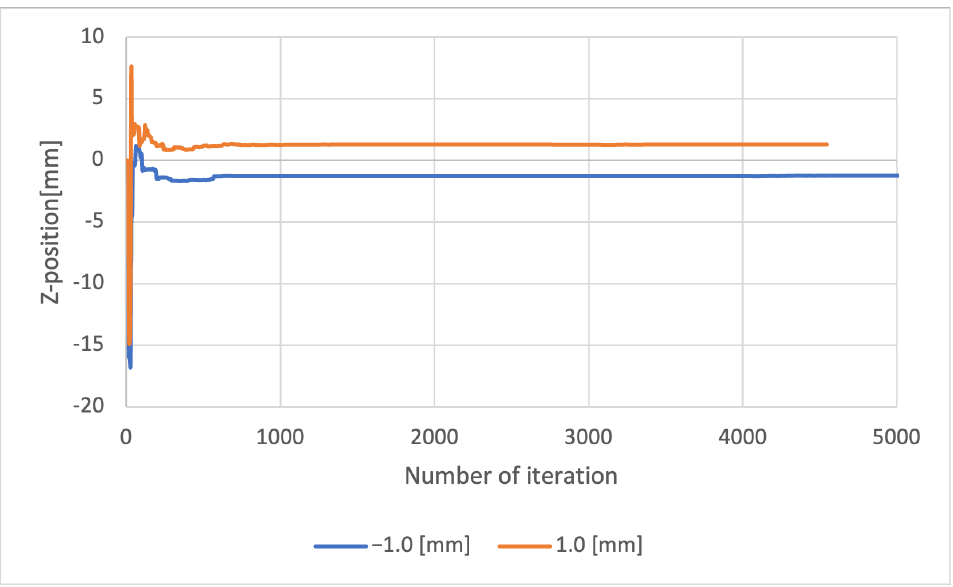
Figure 11. Convergence of iterative calculation of z -axis displacement in Method 1.